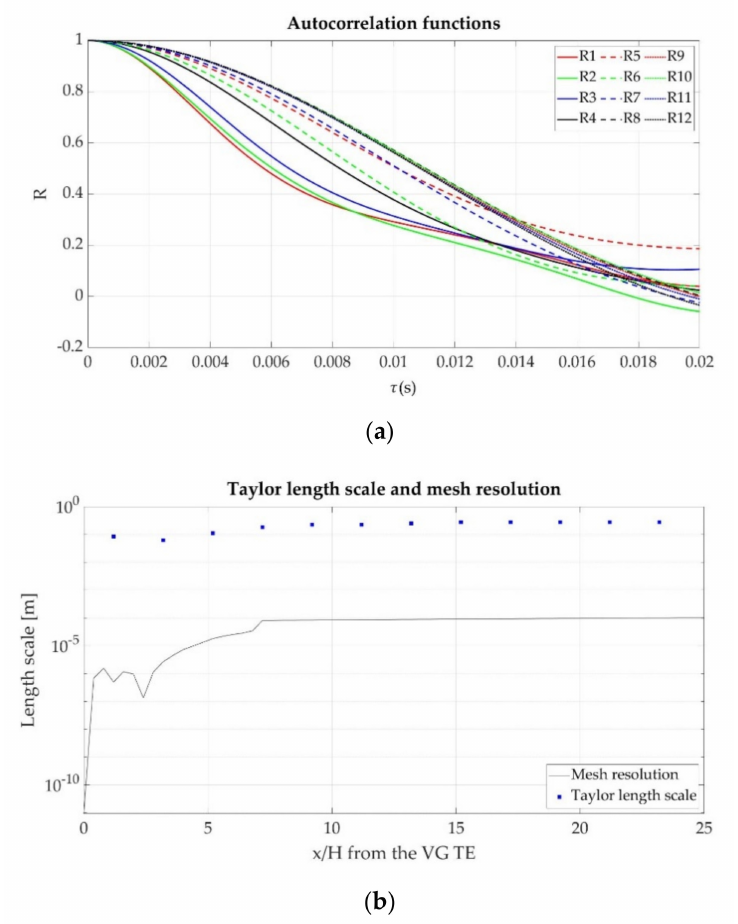
Figure 3. Mesh verification for Large Eddy Simulation (LES): ( a ) Autocorrelation functions; ( b ) Taylor length scale and mesh